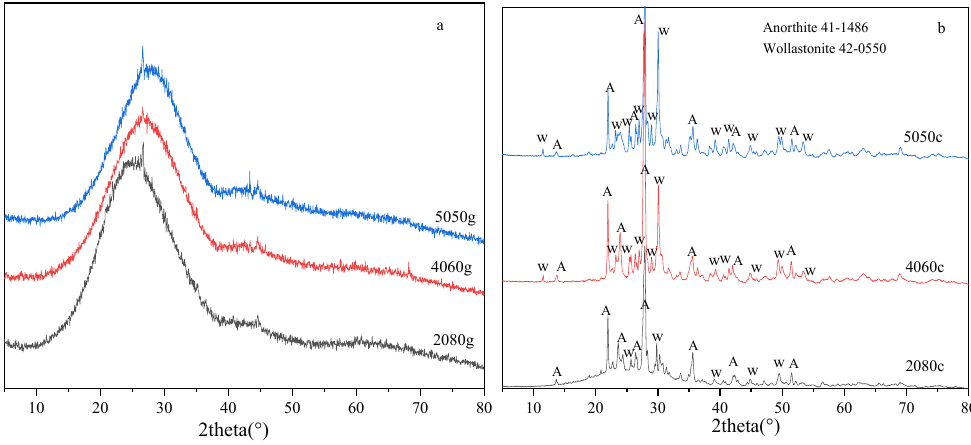
Figure 3. XRD patterns obtained from the glass ( a ) and glass ceramic ( b ) samples. The major crystalline phases of the glass ceramic samples were anorthite (JCPDS No.